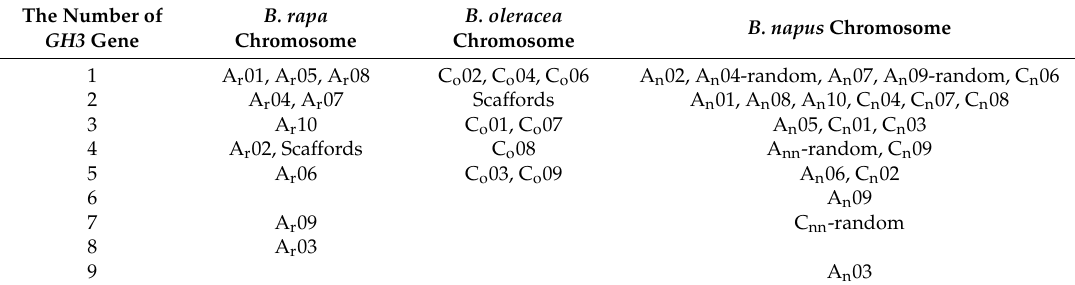
Table 2. The number of GH3 genes on each chromosome.